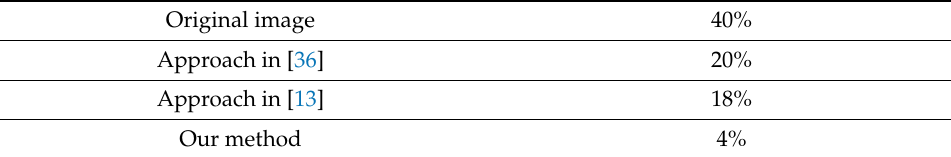
Table 1. The performance of OCR (error rate Er).